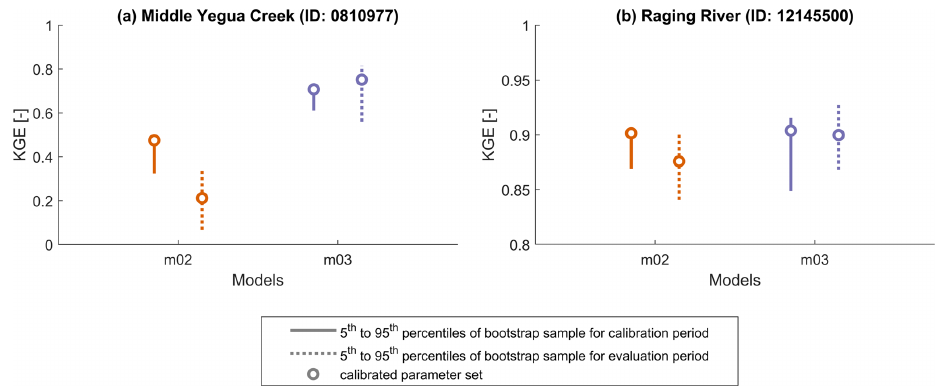
Figure 4. Sampling uncertainty in KGE calculation, quantified as the 5th to 95th percentile of the bootstrap samples performed by the gumboot package. Note the different scales on the y axes.